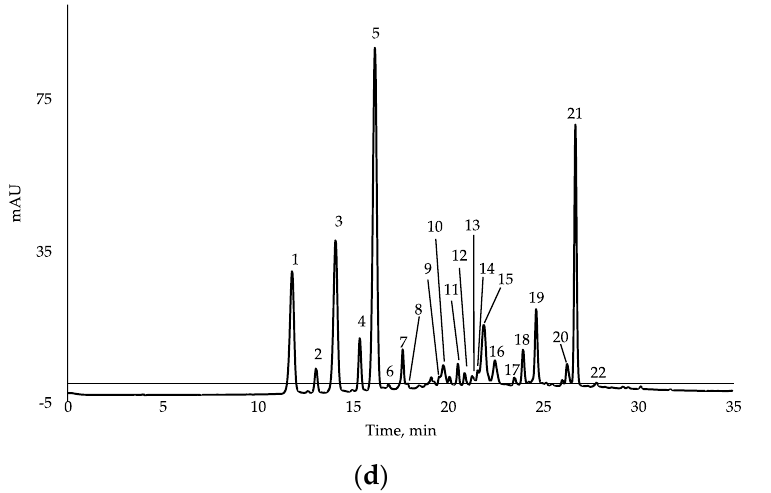
Figure 1. HPLC/DAD chromatogram ( λ = 520 nm) of anthocyanins in four grape marcs. ( a ) Negroamaro; ( b ) Malvasia di Lecce; ( c ) Primitivo; ( d ) Cabernet Sauvignon. For identification of compounds see Table 2.